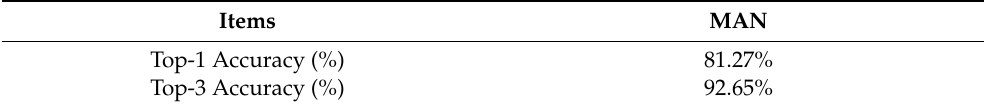
Table 1. Test results with MAN in the GPIAD dataset.